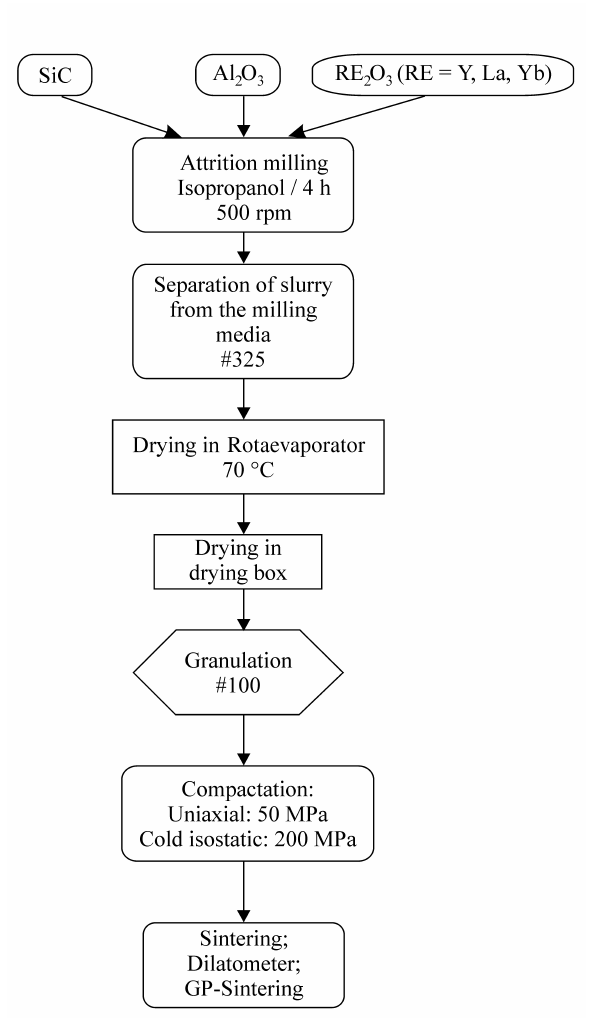
Figure 2. The flowchart of the materials processing. Table 1. Characteristics of the starting powder and powders mixtures.